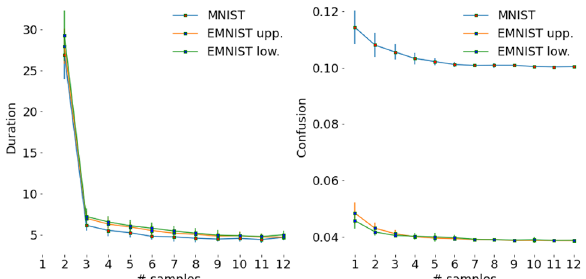
Figure 4. (Left) Errorbar plot of time difference (seconds) between consecutive samples averaged over all classes. That is, value shown at sampling episode t is the time elapsed between a participant’s clicks in image at t − 1 and t . (Right) Errorbar plot of confusion averaged over all classes at each episode. Errorbars indicate std. dev.